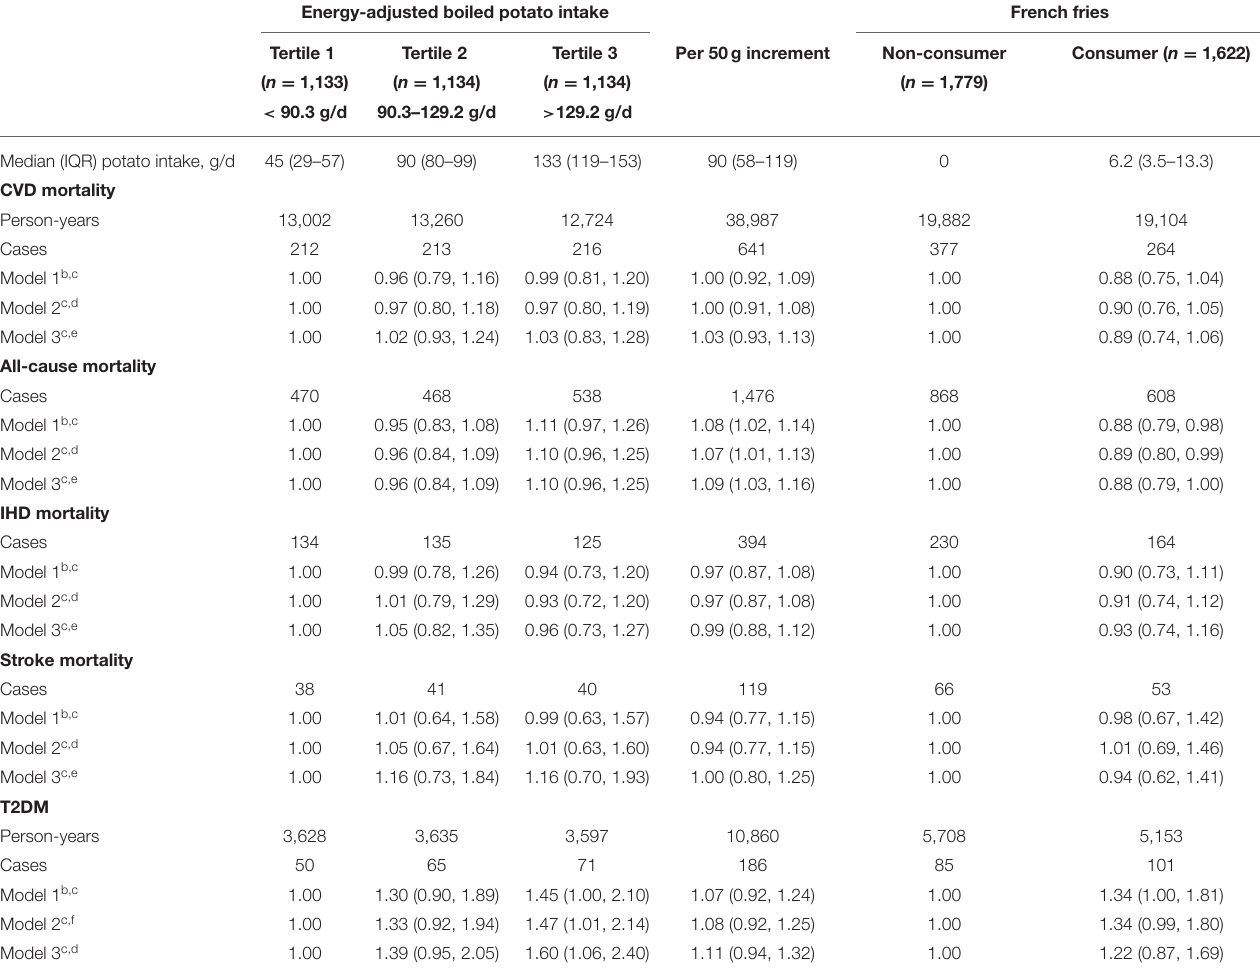
TABLE 3 | Hazard ratios for boiled potato intake and French fries in relation to CVD, all-cause, IHD, stroke mortality, and T2DM incidence in 3,401 patients from the Alpha Omega Cohort a . Energy-adjusted boiled potato